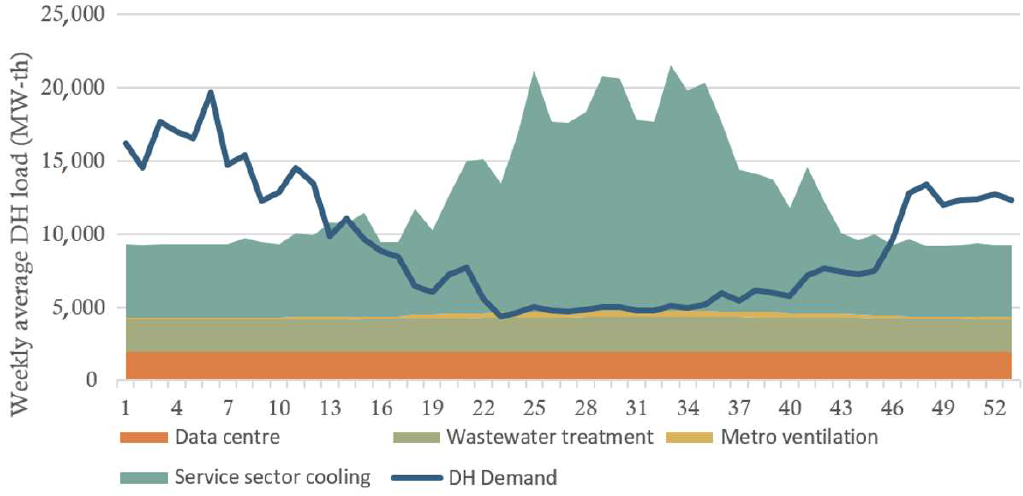
Figure 8. Accessible heat of the four heat sources in Spain in 2050 and the heat demand on weekly resolution.